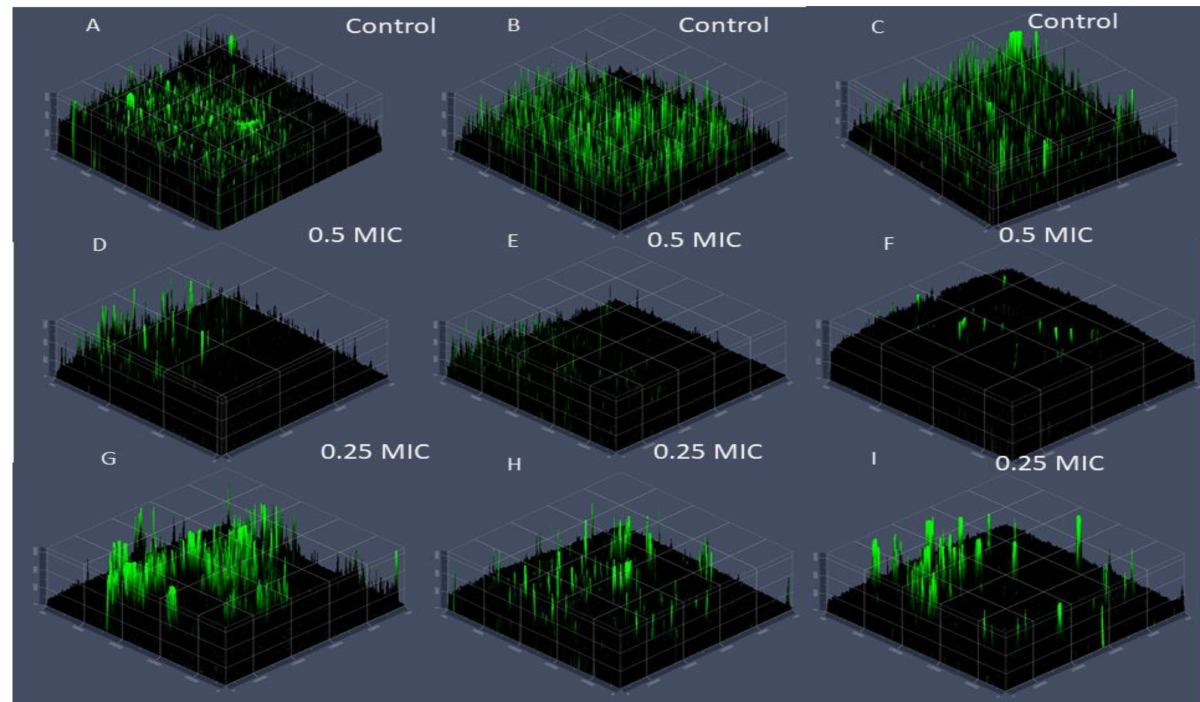
Figure 5. Anti-biofilm activity of green nanocomposite-based biopolymers against Candida parapsilosis ( A , D , G ), C. tropicalis ( B , E , H ) and C. albicans ( C , F , I ) through confocal laser scanning microscopy (2.5D view). Arrows indicate the thickness of Candida